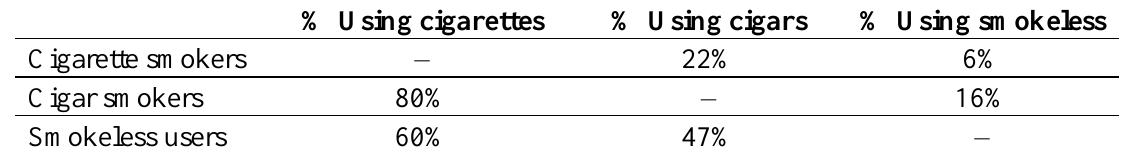
Table 5. Dual use of tobacco products among WV LGB tobacco